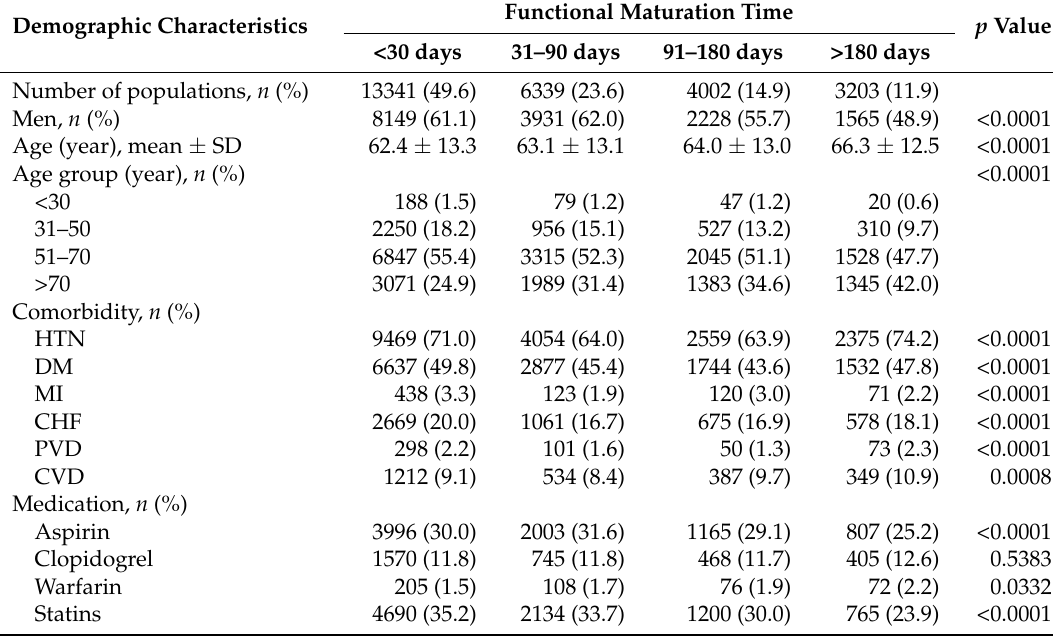
Table 1. Characteristics of ESRD patients with AVF ( N =